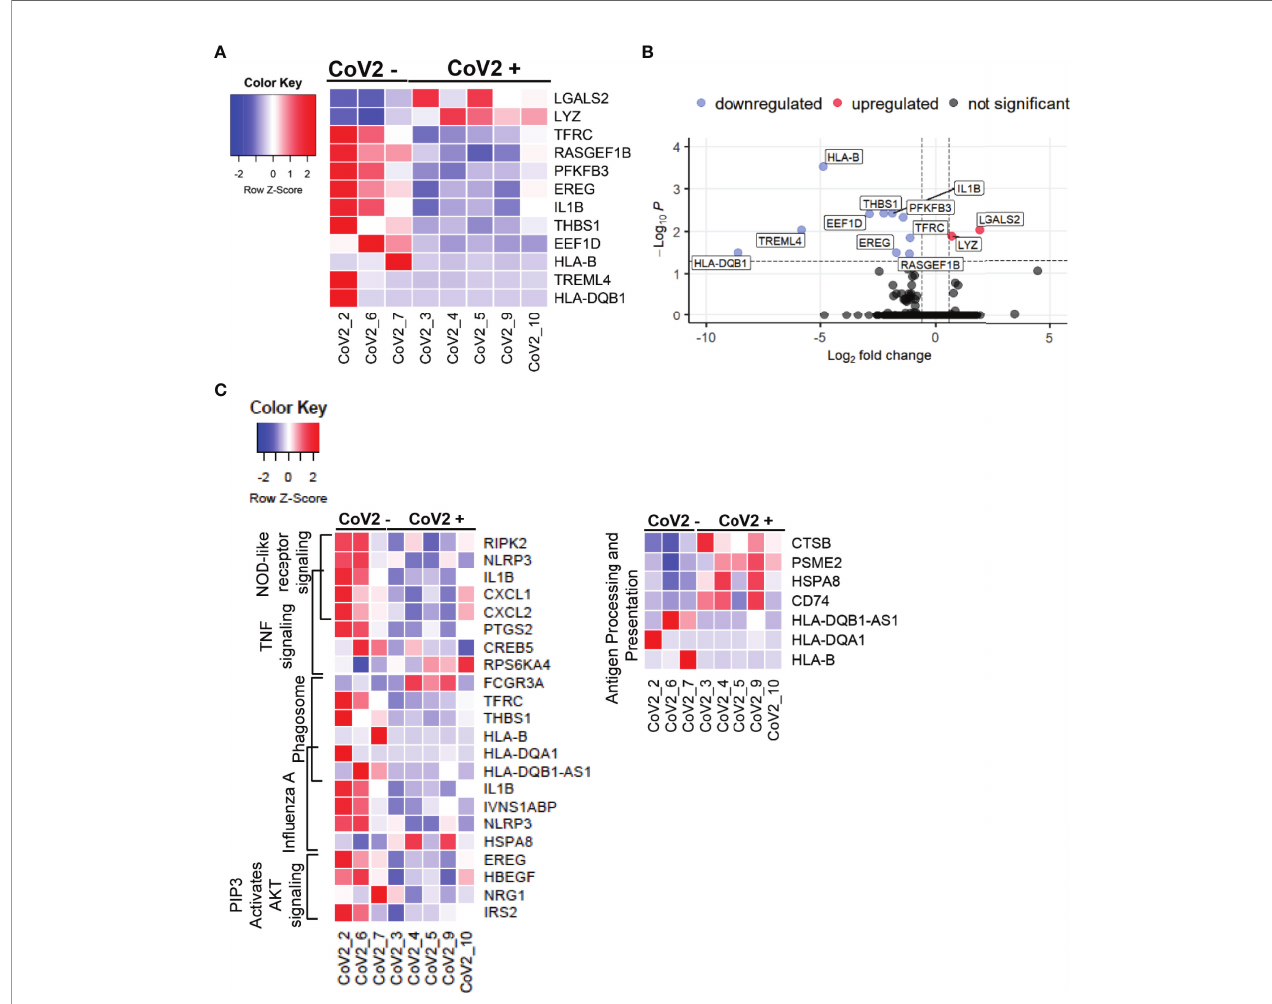
FIGURE 7 | CoV2 infection induces long-term changes in global gene expression pro fi les: Differentially expressed genes in M-MDSC isolated from CoV2- and CoV2+ individuals were identi fi ed using EdgeR . (A) Heatmap was constructed using function heatmap.2 from the library gplots in R. For the heatmap construction, samples were arranged by group (Cov2- followed by CoV2+), and genes were arranged by the average fold change in expression CoV2+/CoV2- (greatest to least); construction of dendrograms was omitted. Gene expression was scaled by row; scale bar represents scaled gene expression values. (B) Volcano plot was constructed using EnhancedVolcano function from the library EnhancedVolcano in R. The input for the volcano plot consisted of gene symbols along with logFC and FDR from the EdgeR differential gene expression analysis output. Vertical dash lines represent the fold change cut off (greater than 1.5 or less than -1.5); horizontal dash line represents the FDR cut off (less than 0.05). (C) Heatmaps were constructed for genes (nominal p < 0.05) from selected pathways (indicated on the left of the heatmaps). Samples were arranged by group (Cov2- followed by CoV2+). Genes were arranged by pathway; genes mapped to two pathways were added to the heatmap once at their